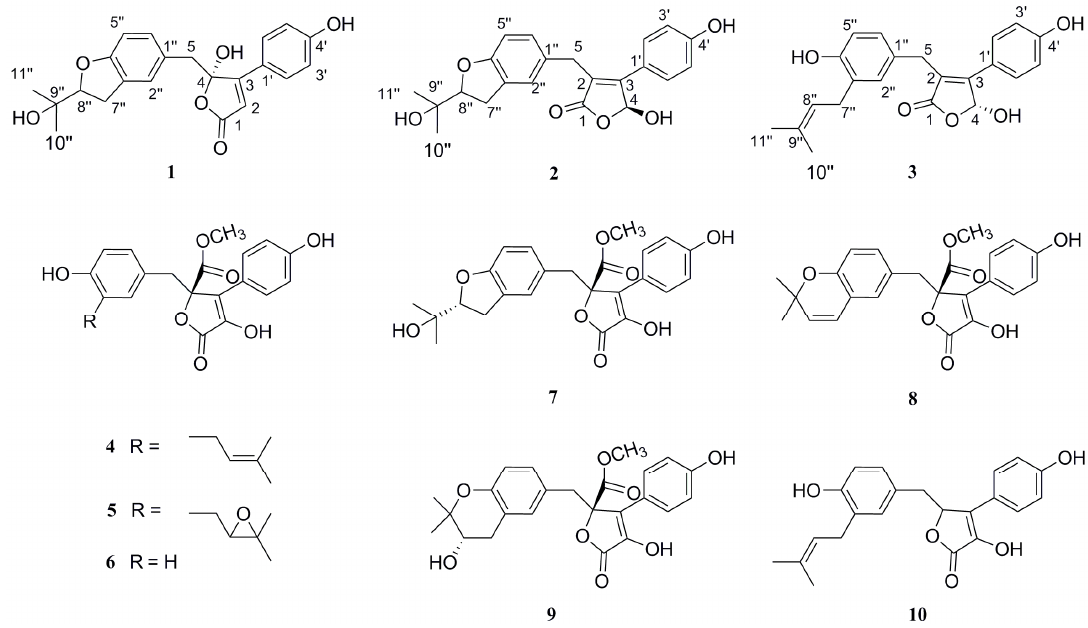
Figure 1. The structures of compounds 1 – 10 .